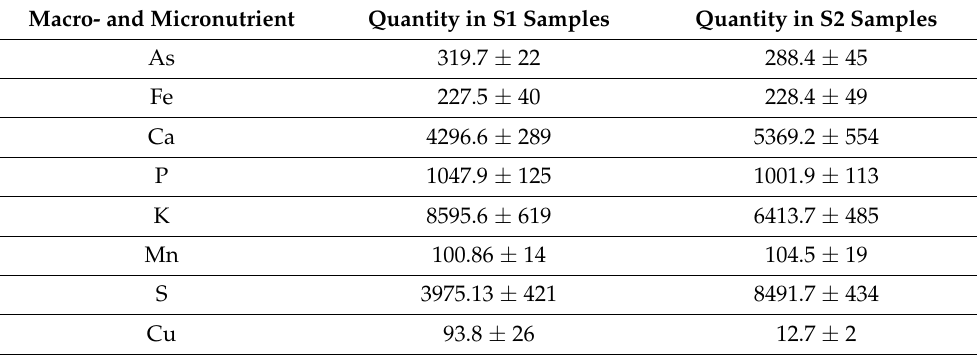
Table 4. Macro- and micronutrient contents (mg/kg ± Standard Error (SE)) measured by µ XRF, in samples collected from P. vittata plants grown on S1 and S2 soils, characterised by similar As content. Macro- and